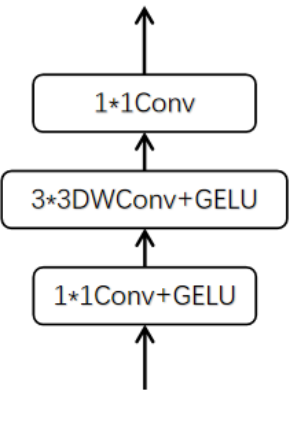
Figure 4. Structure of